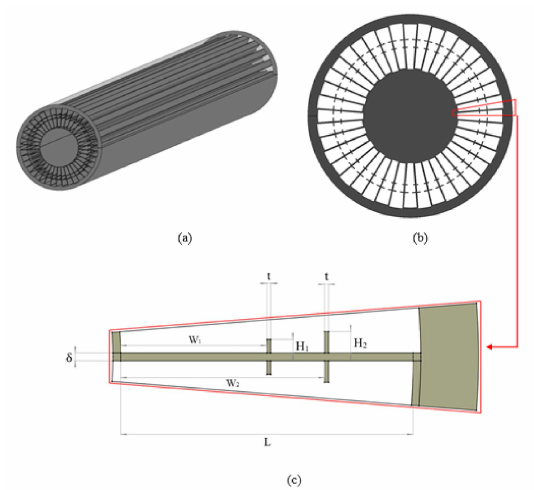
Figure 5. The physical model of design C PTHE-ZR. ( a ) three-dimensional view, ( b ) cross-sectional view and ( c ) computational region.